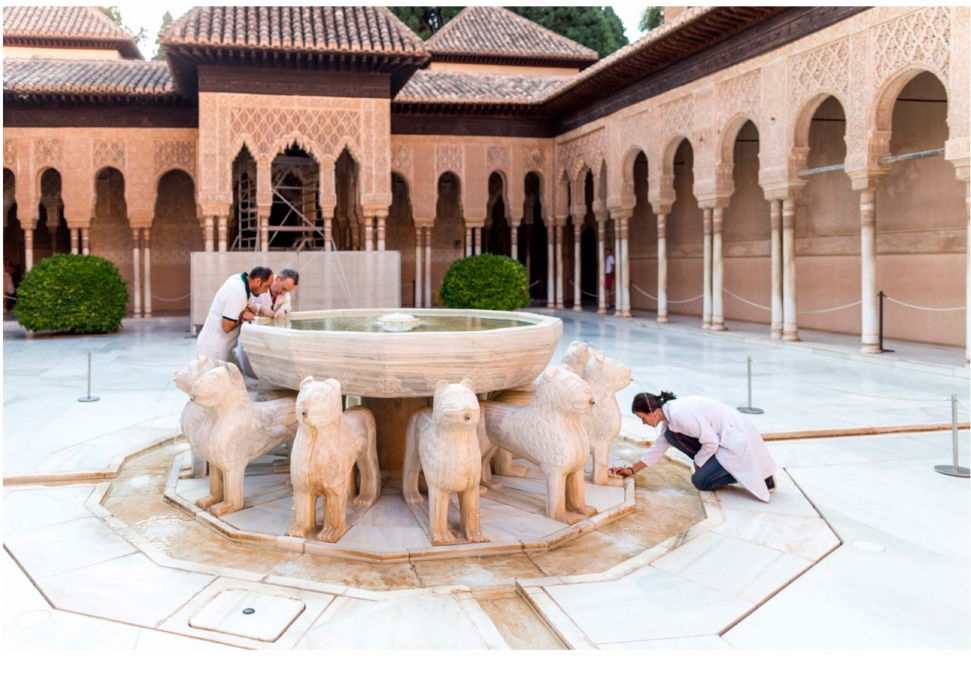
Figure 2. Sampling from the Fountain of the Lions. Photo by G. Alfano.